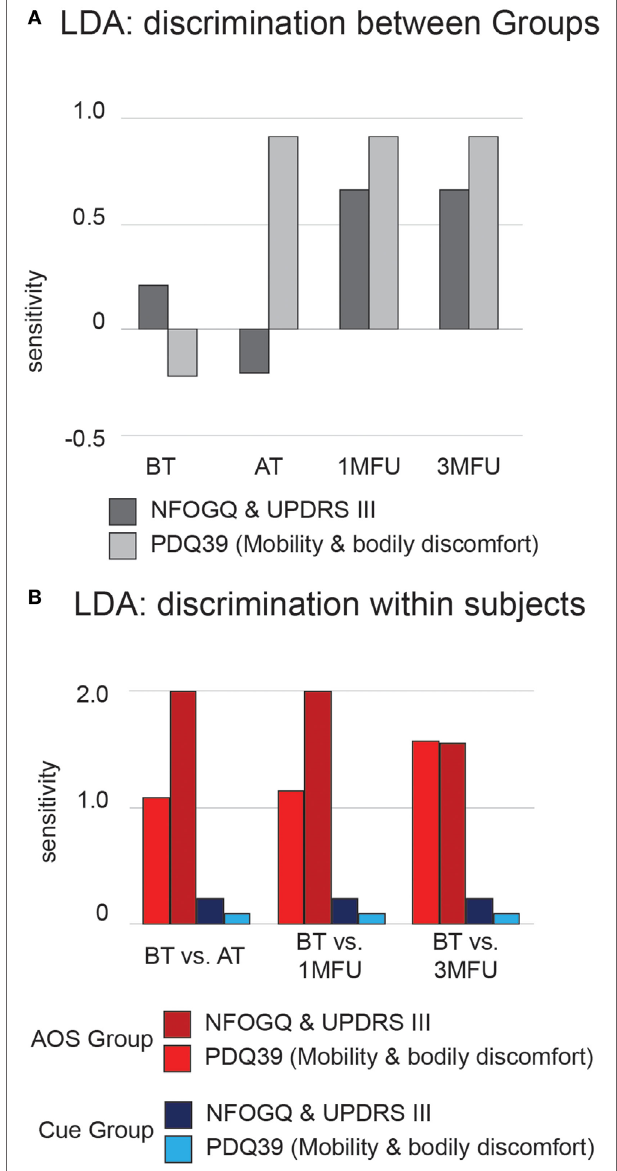
FiGUrE 4 | Average discrimination accuracy expressed in terms of sensitivity ( d ′ ) of the linear discriminant analysis (LDA) algorithm. (a) Results of testing between-groups’ discrimination. Dark gray bars represent LDA results from the New Freezing of Gait Questionnaire (NFOGQ) and UPDRS III scales. Light gray bars represent LDA results from the PDQ39 mobility and bodily discomfort scales. (b) Results of testing within-subject discrimination. Dark and light red bars represent LDA results from the NFOGQ and UPDRS III scales for the Action Observation plus Sonification experimental group. Dark and light blue bars represent LDA results from the PDQ39 mobility and bodily discomfort scales, for the Cue control group.